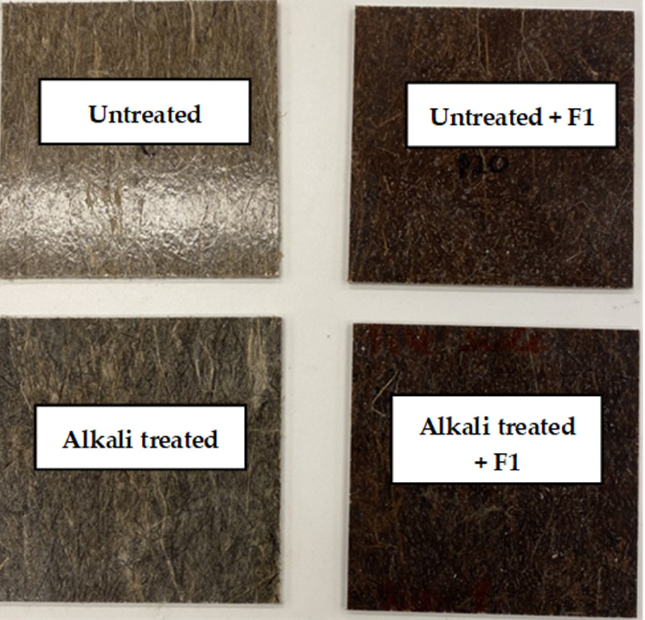
Figure 4. Some batches of the fabricated biocomposites showing the color changes induced by the alkali treatment and F1 coating.